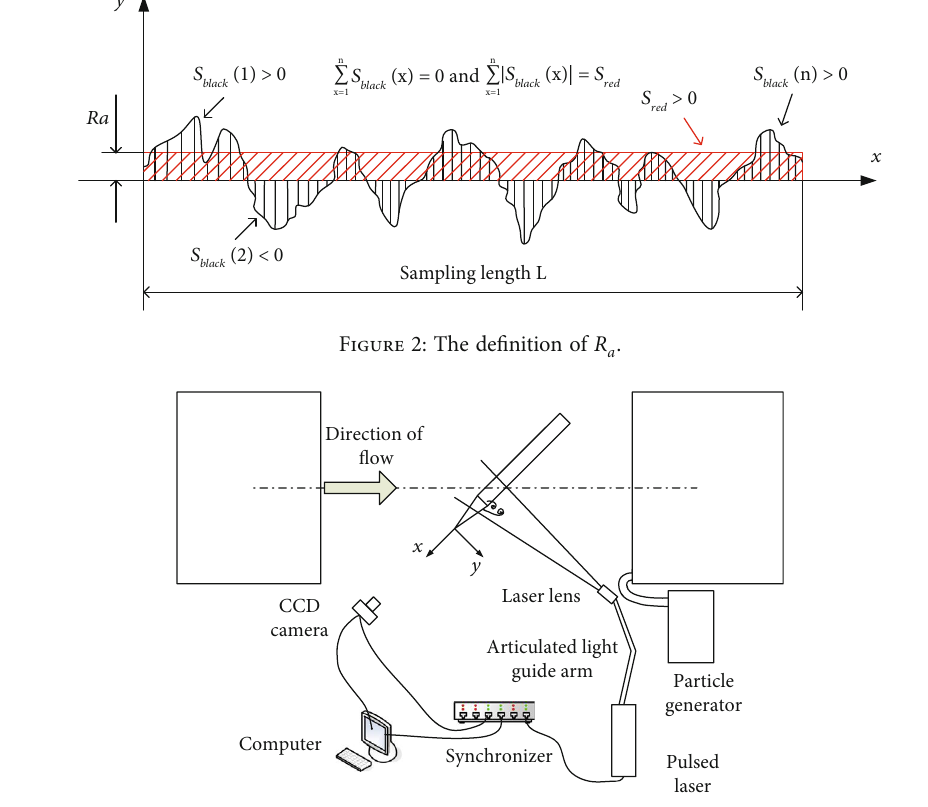
Figure 3: Schematic of PIV experiment. Table 1: The performance indexes of balance